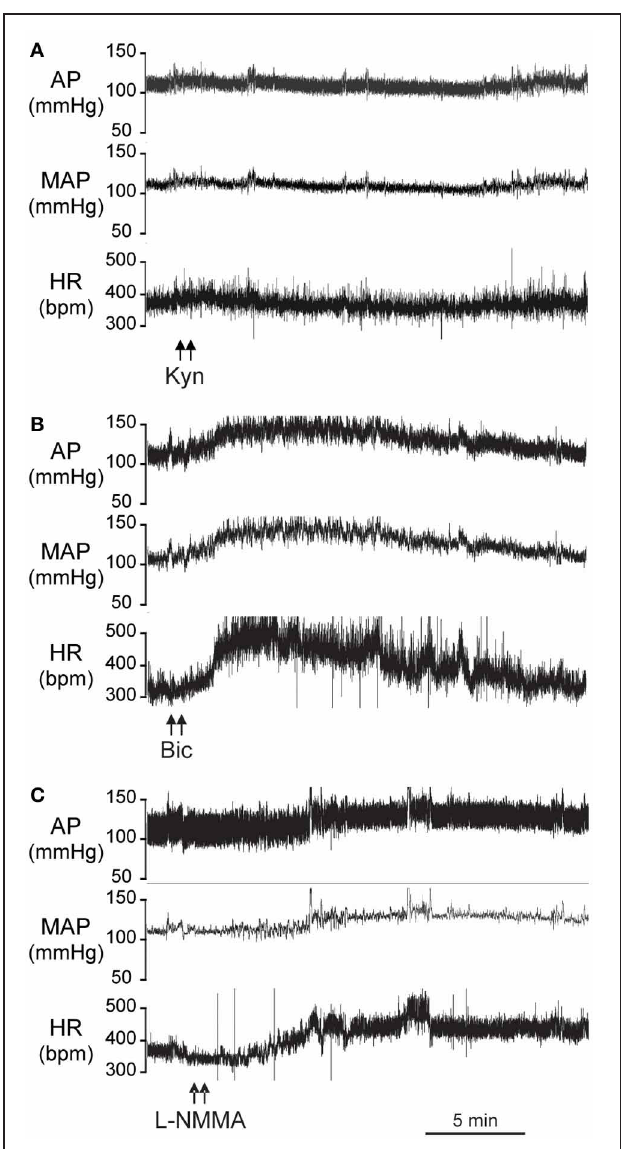
FIGURE 2 | Original records from individual conscious rats showing the arterial pressure (AP), Mean AP (MAP), and heart rate (HR) responses to bilateral microinjections (100nl) into the PVN of: (A) Kynurenic acid (Kyn, 40mM); (B) Bicuculline (Bic, 1mM); (C) L-NMMA (2mM).